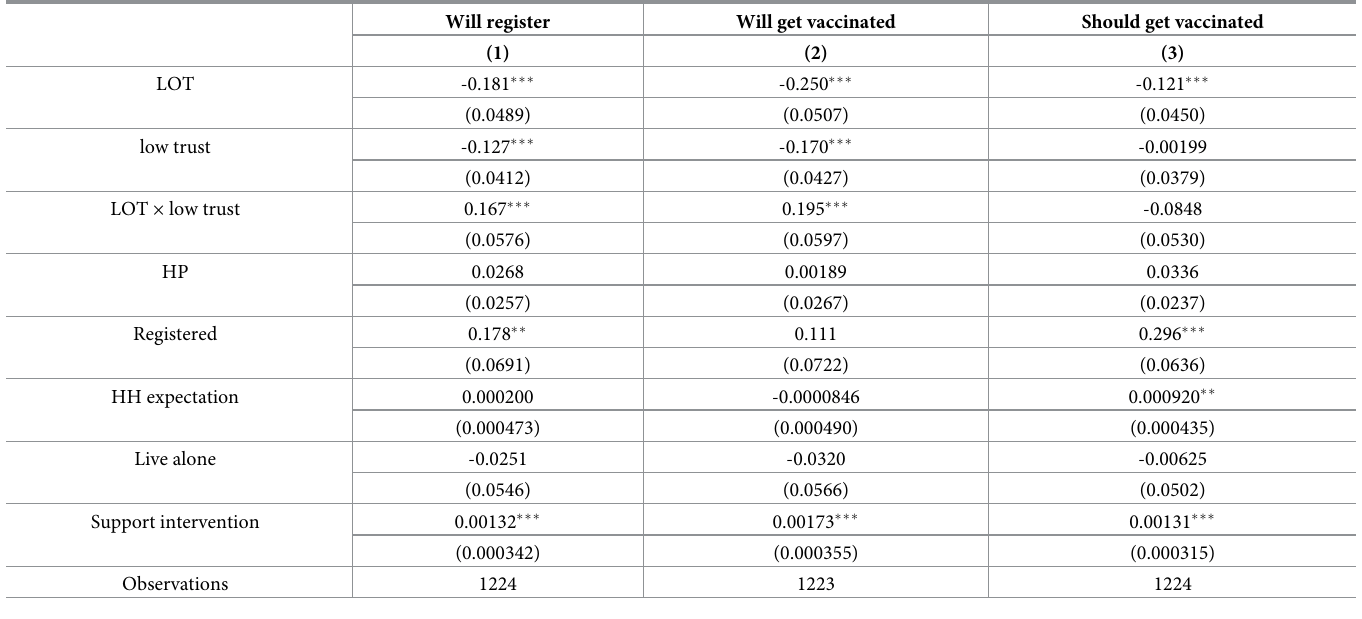
Table 8 aims to explain the effect of incentives, norms and beliefs on the protagonist’s expected behavior. Under the PUN, low trust is strongly associated with LP and vaccination, but has no significant relationship with norms. Under LOT manipulation, by contrast, low trust has no significant relationship with behavior or norms, and therefore the relative efficacy of LOT in driving behavior is significantly higher for low-trust individuals relative to high- trust individuals. The generally lower efficacy of LOT on behavior is almost entirely driven by high-trust respondents. Thus, while we have strong evidence of the behavioral components that support pro-vaccination, government intervention has a positive relationship with protag- onist’s expected behavior. However, we found no evidence that expectations of social pro-vac- cination behaviour will project into the likelihood of protagonists adjusting their behavior and getting the vaccine. Table 8. Effect of incentives, norms, and beliefs on hypothetical vaccination